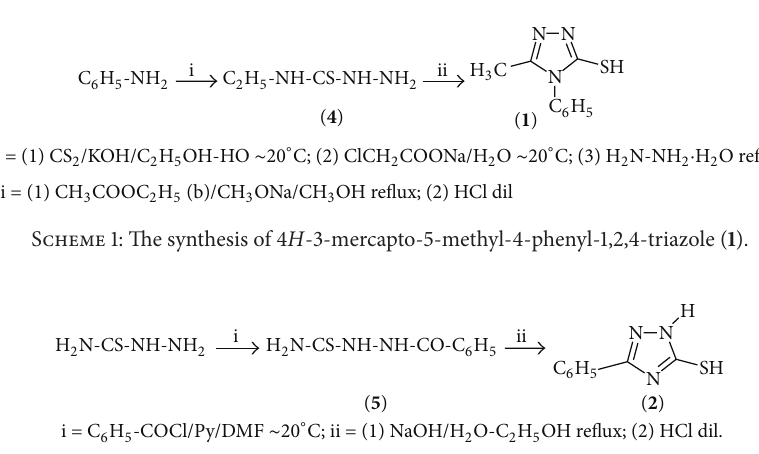
Scheme 2: The synthesis of 1 H -5-mercapto-3-phenyl-1,2,4-triazole ( 2